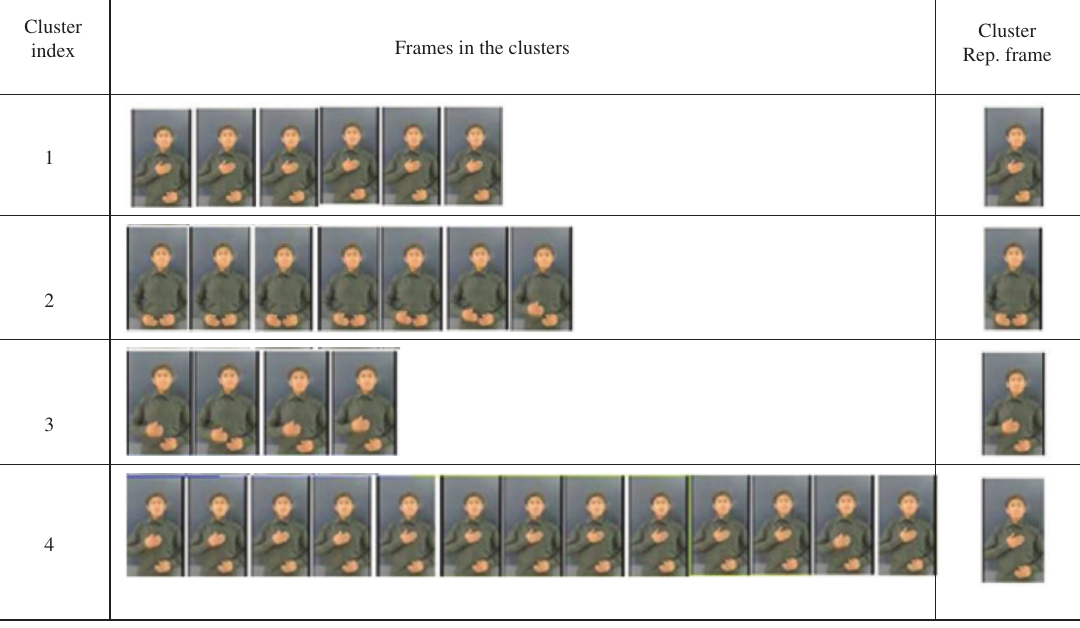
Figure 3: Few Frames from the Sign “I Want Coffee” Used to Show the Cluster Representative Selection Process. Table 1: Clusters and the Frames within the Clusters. Cluster index Frames within the clusters Cluster